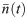
Agent-based realisation compared to predicted means: First cohort of macrophages.In a numerical realisation, N = 30 macrophages are infected, by one bacterium each, at t = 0. The red line shows the number of those macrophages surviving up to time t. The dotted red curve is NS(t), using the survival function (5). Each blue dot in the lower panel coincides with a downward step in the red line, corresponding to a macrophage rupture event. The dotted blue curve is n¯(t), given by (11). Parameter values have been taken from Ref. [23]: β = 0.15 h−1, μ = 0 and δ = 0.001 h−1. Agent-based realisations are simulated making use of tau-leaping time-stepping with Δt = 0.01 h−1, M = 104, ρ = 0.01 h−1, ϕ = 2 h−1, μE = 0.01 h−1 and γ = 1 h−1.